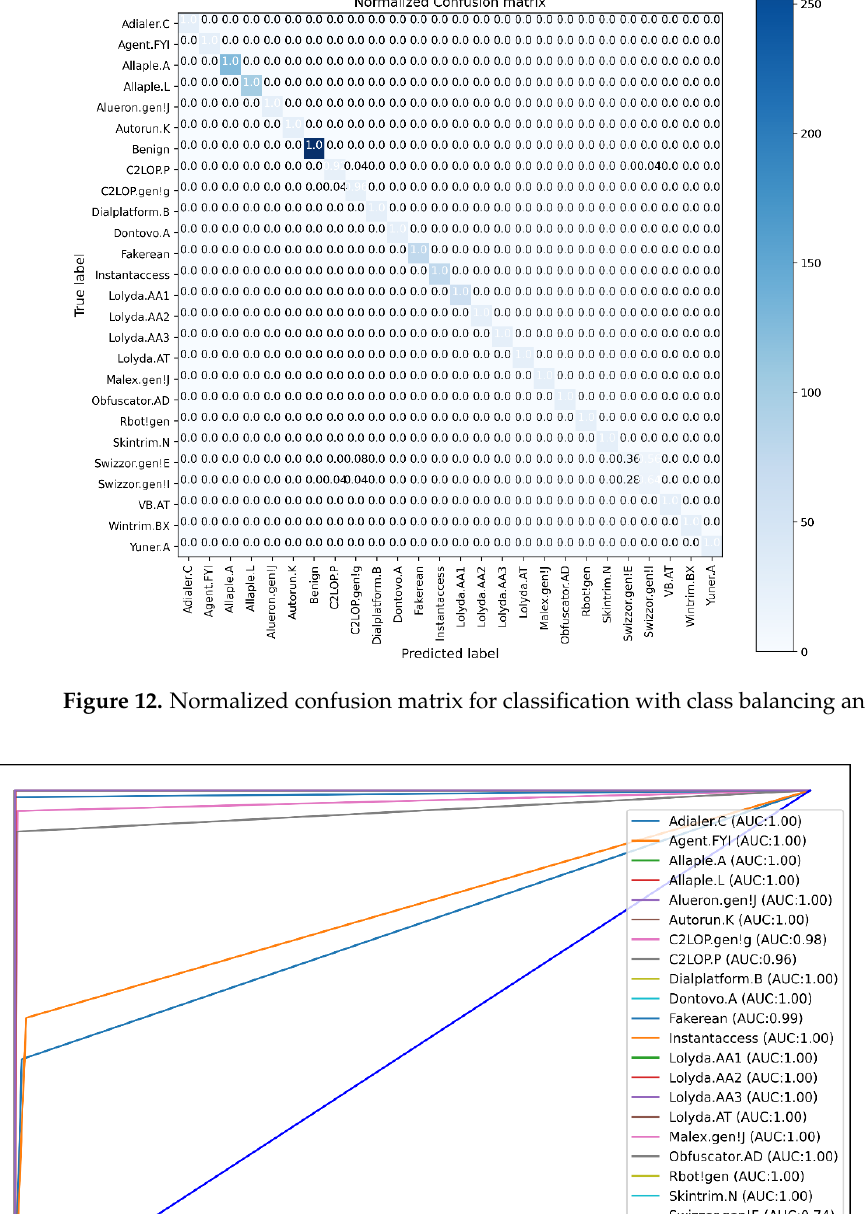
Figure 14. ROC curves with area under curve values for classification with class balancing and benign class.